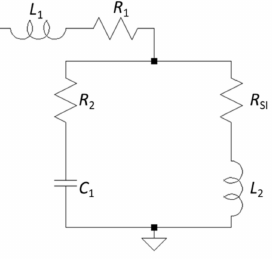
Figure 14. Equivalent circuit of the SI sensor device: R 1 , R 2 , L 1 , L 2 , and C 1 are parasitic elements; R SI is the transducer element.